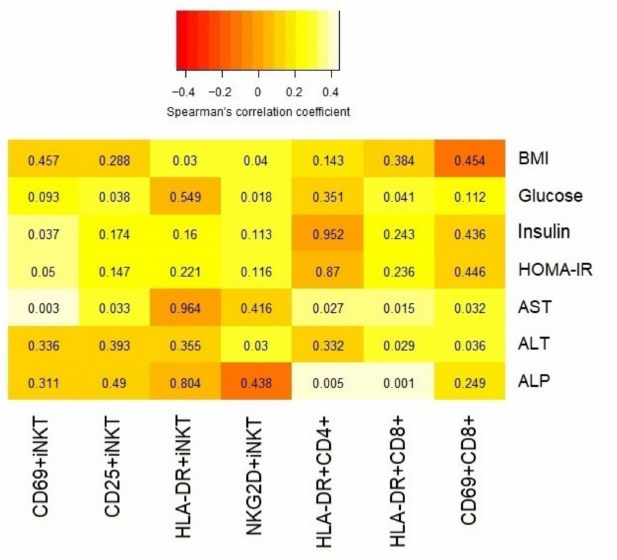
Figure 5. Spearman’s correlations between CD69+iNKT and aspartate aminotransferase (AST) ( A ) and between HLA-DR+CD8+ and alkaline phosphatase (ALP) ( B ) for the whole population (non-alcoholic fatty liver disease (NAFLD), drug-induced liver injury (DILI), and healthy controls).